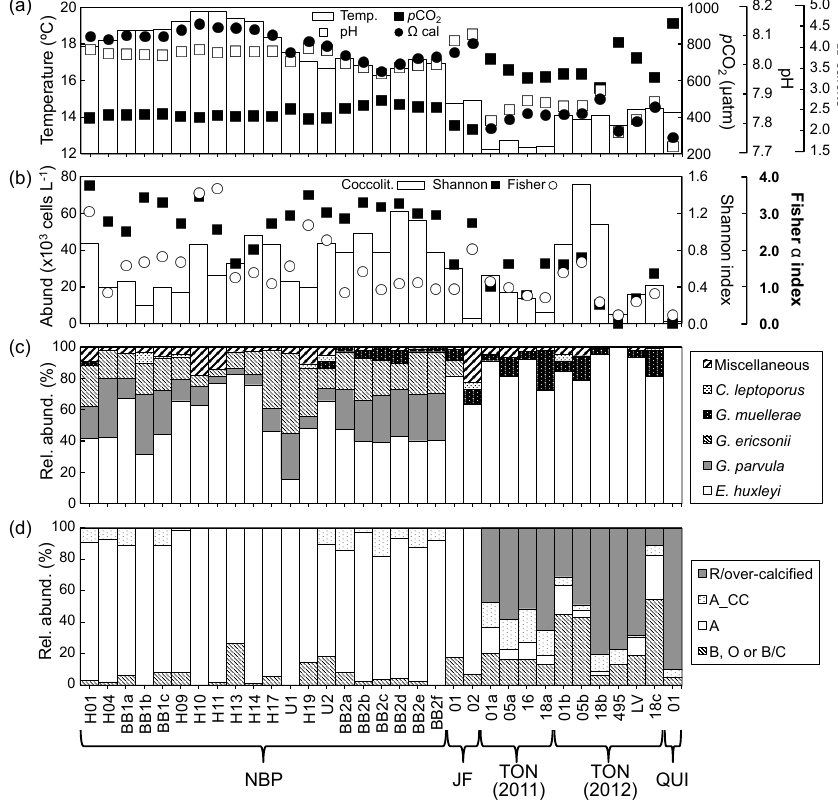
Figure 3. Environmental conditions, coccolithophore community, and E. huxleyi morphotypes. (a) Temperature, pH, CO 2 , and (cid:127) calcite . (b) Coccolithophore abundance and Shannon and Fisher’s alpha diversity indices. (c) Relative abundance of principal coccolithophore taxa. (d) Relative abundance of E. huxleyi morphotypes. The lightly calcified morphotypes B, O, and B/C have been grouped together.